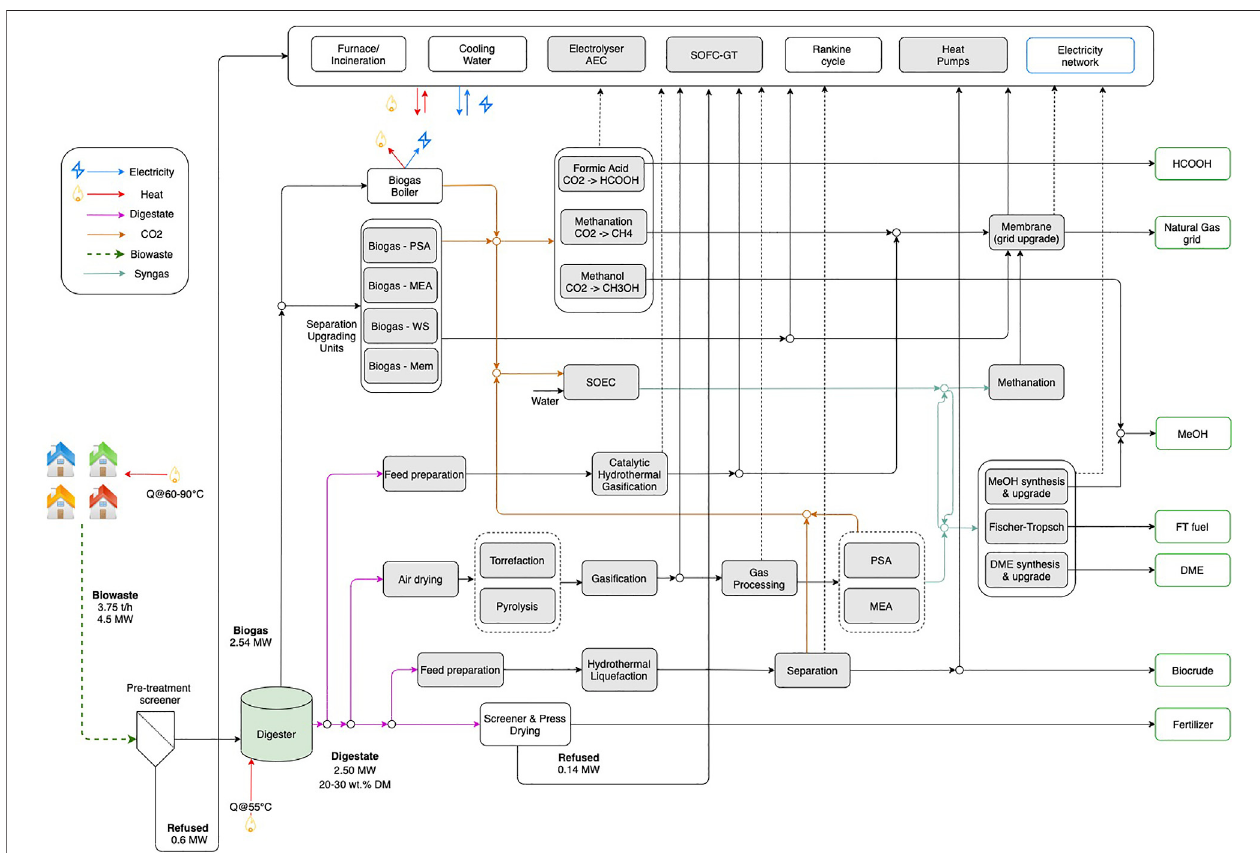
FIGURE 2 | Urban biowaste superstructure with average yearly values. Gray fi ll units are proposed investments. WS - water scrubbing; Mem - polymeric dry membranes.